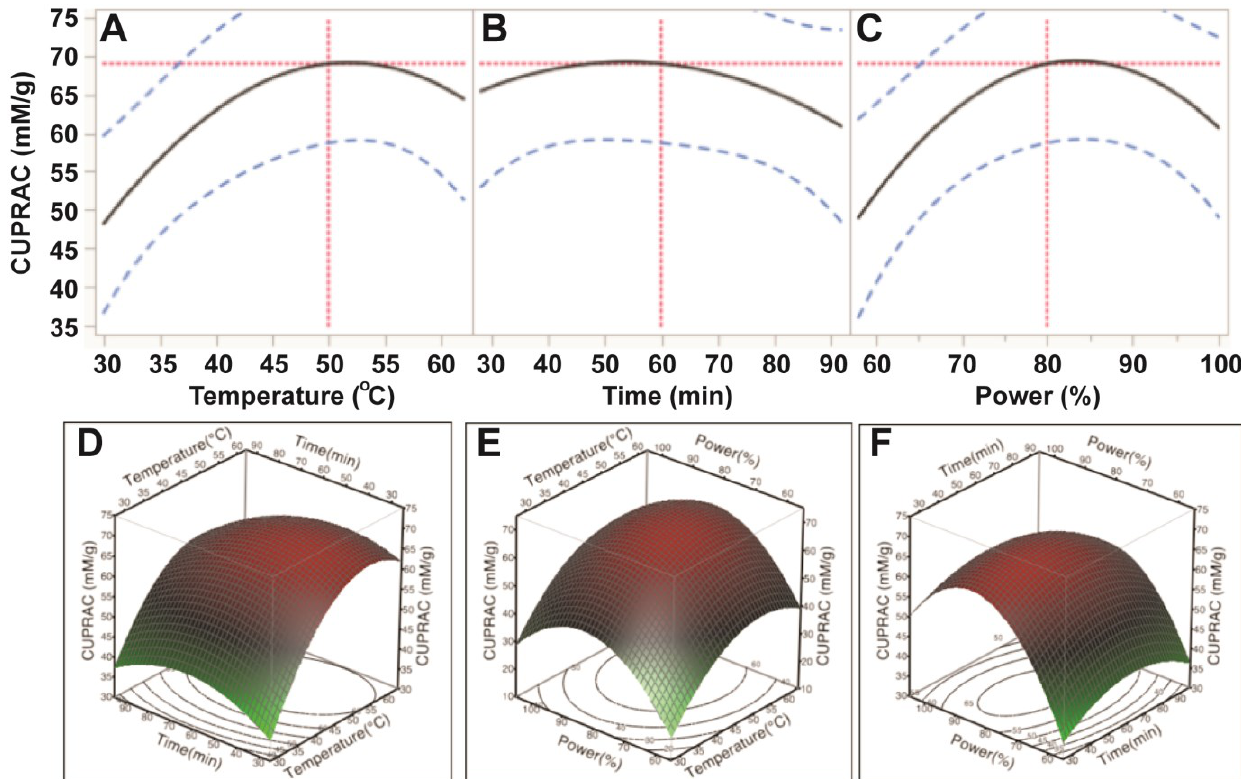
Figure 5. Impact of ultrasonic temperature (30–50 °C), time (30–90 min) and power (60%–100% or 150–250 W) on cupric reducing antioxidant capacity. The 2D impact of temperature, time and power were expressed in Figure 5A–C; while their 3D effects were shown in Figure